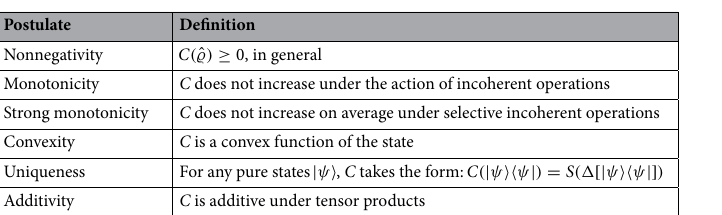
1 and c 0.5 10 7 s 2 γ . − = × =